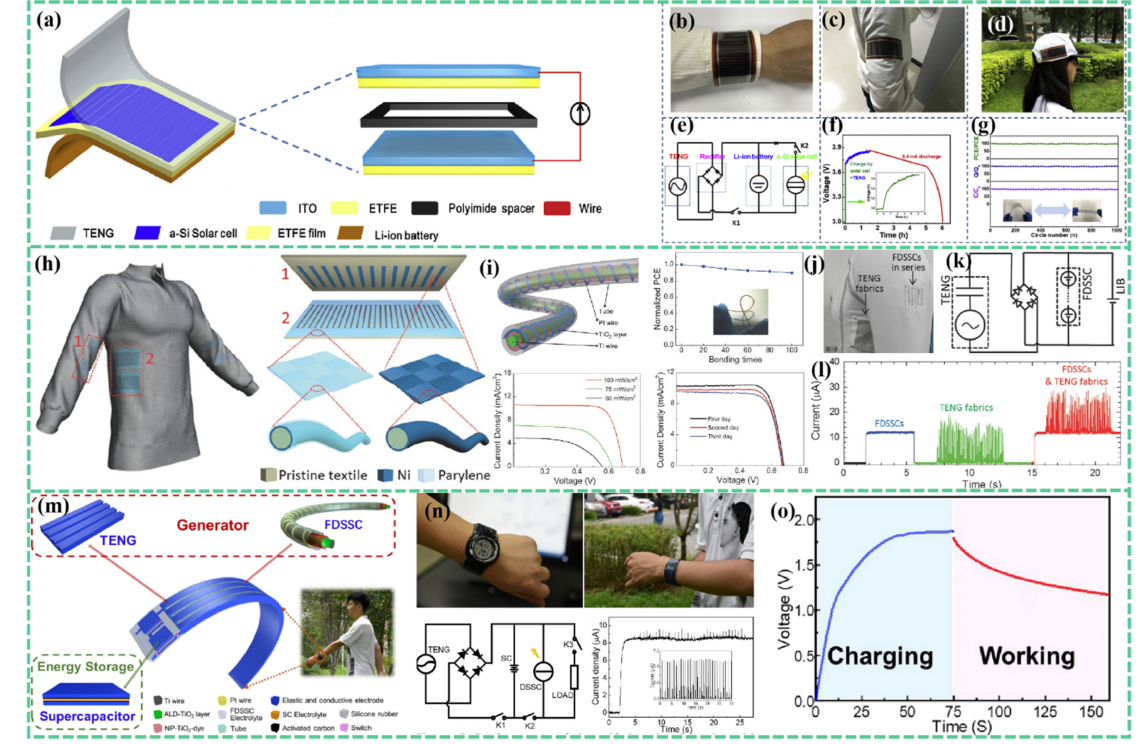
Figure 11. Wearable TENG-UPS device with hybrid energy collection method. ( a – g ) A flexible TENG-UPS panel for harvesting and storing solar and mechanical energy. ( a ) Structure diagram of the hybridized flexible energy harvesting device. ( b – d ) Photograph of the wearable energy harvesting device attached to the textiles of wrist. ( e ) Equivalent circuit of hybrid harvesting system. ( f ) Voltage distribution and corresponding discharge curve of the hybrid system. ( g ) The PCE value of the solar cell, the Q sc value of TENG, and the capacity of the LIB to bend 1000 times between 0 ◦ and 120 ◦ . Reproduced with permission [108]. Copyright 2019, Elsevier Ltd. ( h – l ) A wearable power textile integrating a fabric TENG and a fibrous dye-sensitized solar cell. ( h ) The scheme of the configuration of the TENG fabrics. ( i ) Fiber-shaped dye-sensitized solar cell. ( j ) A photo of a power- textile with a pair of TENG fabrics. ( k ) Equivalent circuit of TENG-UPS. ( l ) The short-circuit current of FDSSCs, TENG fabrics, and the hybrid energy-harvesting device. Reproduced with permission [109]. Copyright 2016, Wiley-VCH. ( m – o ) A highly elastic uninterruptible power supply that collects both solar energy and mechanical energy. ( m ) Schematic of the UPS bracelet. ( n ) Performance of the self-charging bracelet with SCs, FDSSCs, and TENGs. ( o ) The voltage profile of the SCs charged by the harvesting devices, and corresponding working curve for powering an electronic watch. Reproduced with permission [110]. Copyright 2019, Elsevier